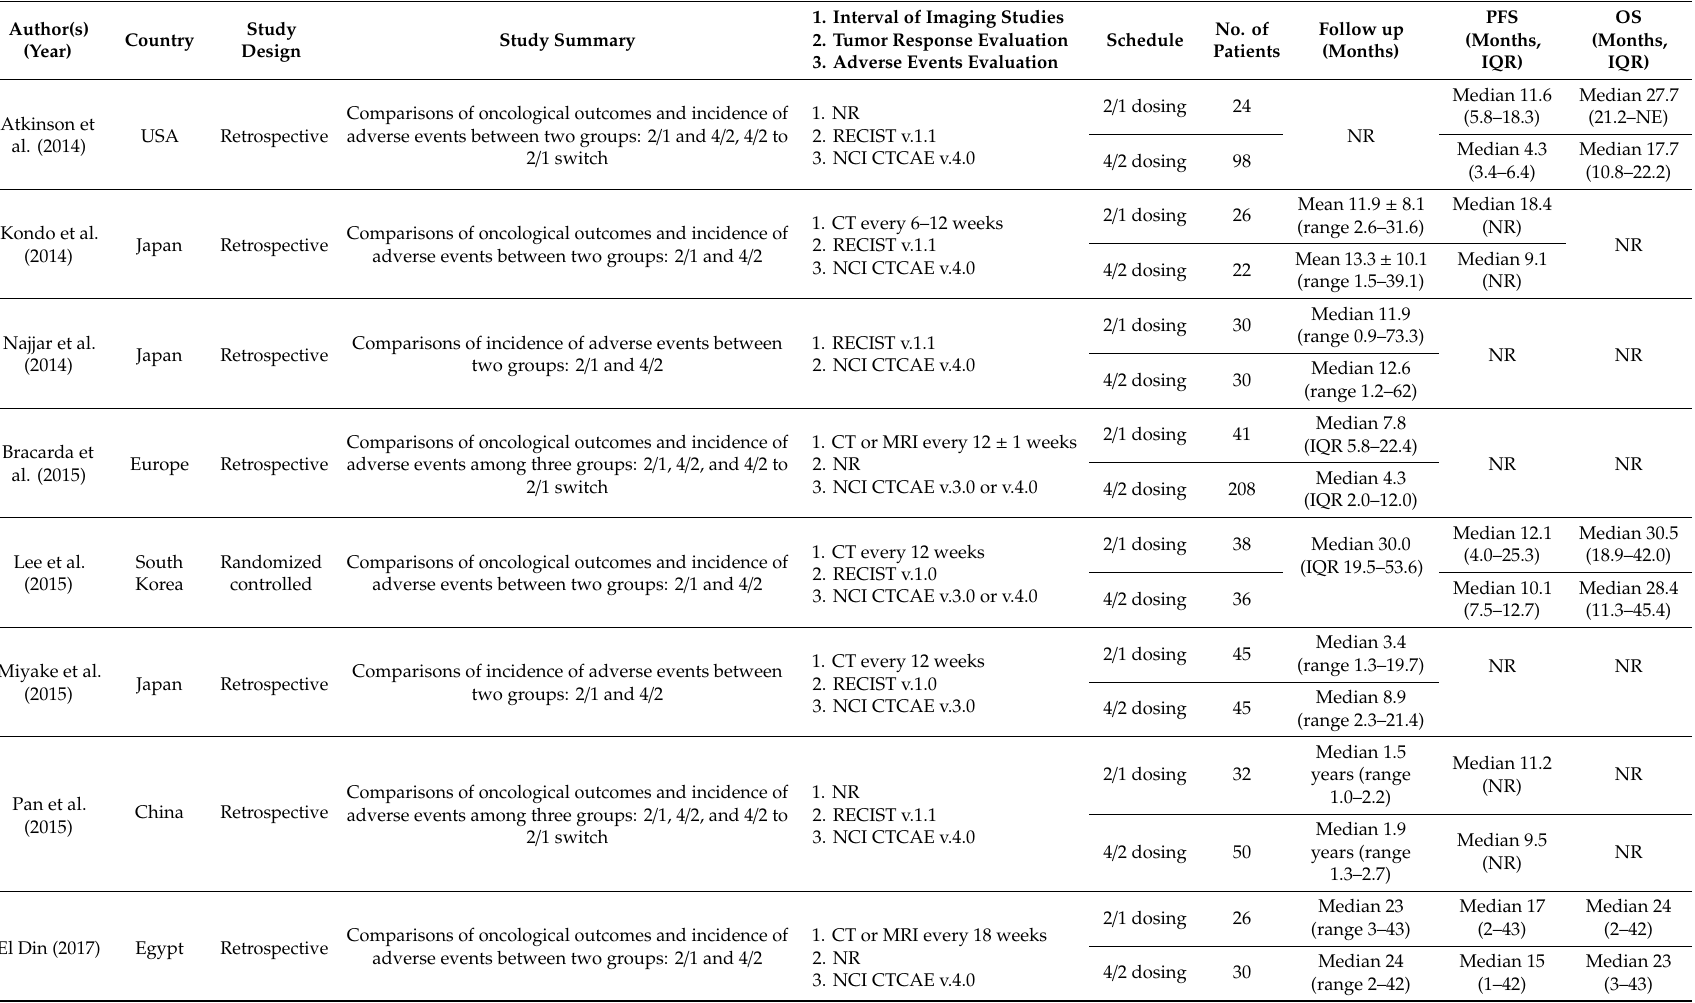
Table 1. Characteristics of eligible